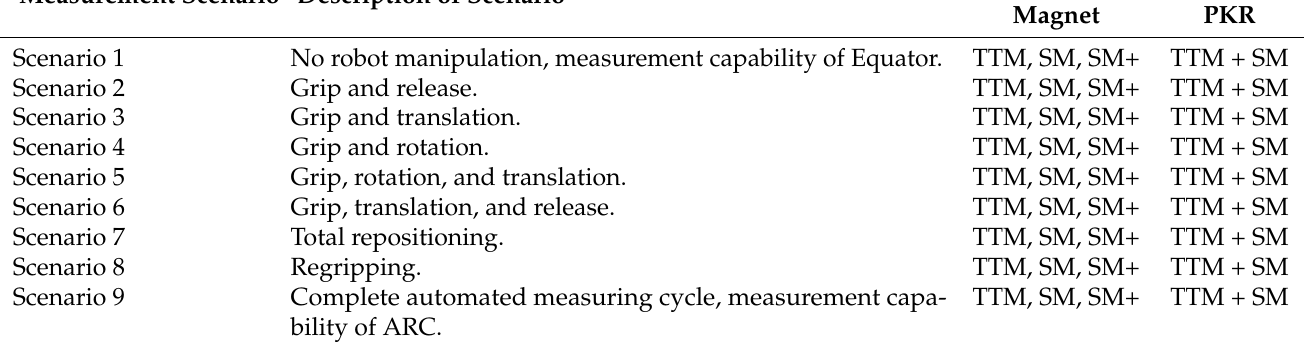
Measurement Method Used Magnet PKR